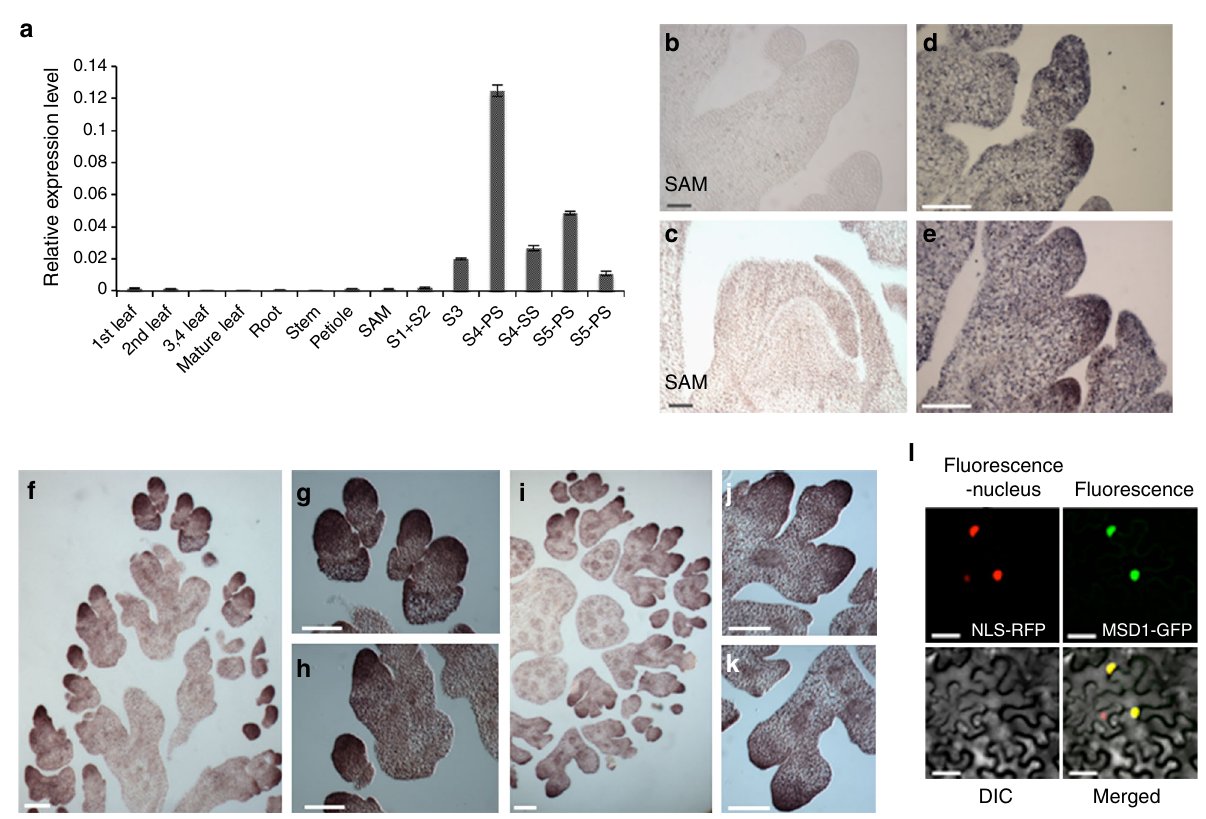
Fig. 3 MSD1 expression analysis in wild type. a Relative expression of MSD1 from qRT-PCR in various tissue types, including leaf, root, stem, petiole, SAM, and in fl orescence (stages 1 + 2, 3, and 4) of PS, SS (stage 4), PS (stage 5), and SS (stage 5). The bars represent mean ± SD of three biological replicates. b – k In situ hybridization of MSD1 during in fl orescence development in WT: b Spikelet meristem in stage 2, labeled with sense probe as a negative control. c Longitudinal view of shoot apical meristem. d Spikelet meristem near the top of meristem in stage 2, labeled with antisense probe. e Spikelet meristem at the bottom of meristem in stage 2. f – h Longitudinal section of fl oral meristem in early stage 3. g and h show magni fi cations of the fl oral meristem. i – k Transverse section of fl oral meristem in early stage 3. Magni fi cations of the fl oral meristem at early stage 3 in i are shown in j and k . l Cellular localization of MSD1: confocal images showing MSD1 – green fl uorescent protein (GFP) localization in tobacco transient assay. Top left: Nuclear Localization Sequence (NLS)-red fl uorescent protein (RFP) (control); top right: MSD1-GFP; bottom left: differential interference contrast (DIC) image; bottom right: merged image of NLS-RFP and MSD1-GFP. b – k Bar: 100 μ m. I Bar: 50 μ